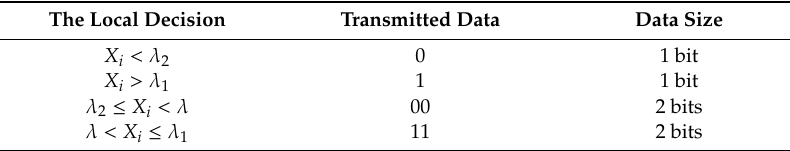
Table 1. The transmitted data and data size of the local decision.